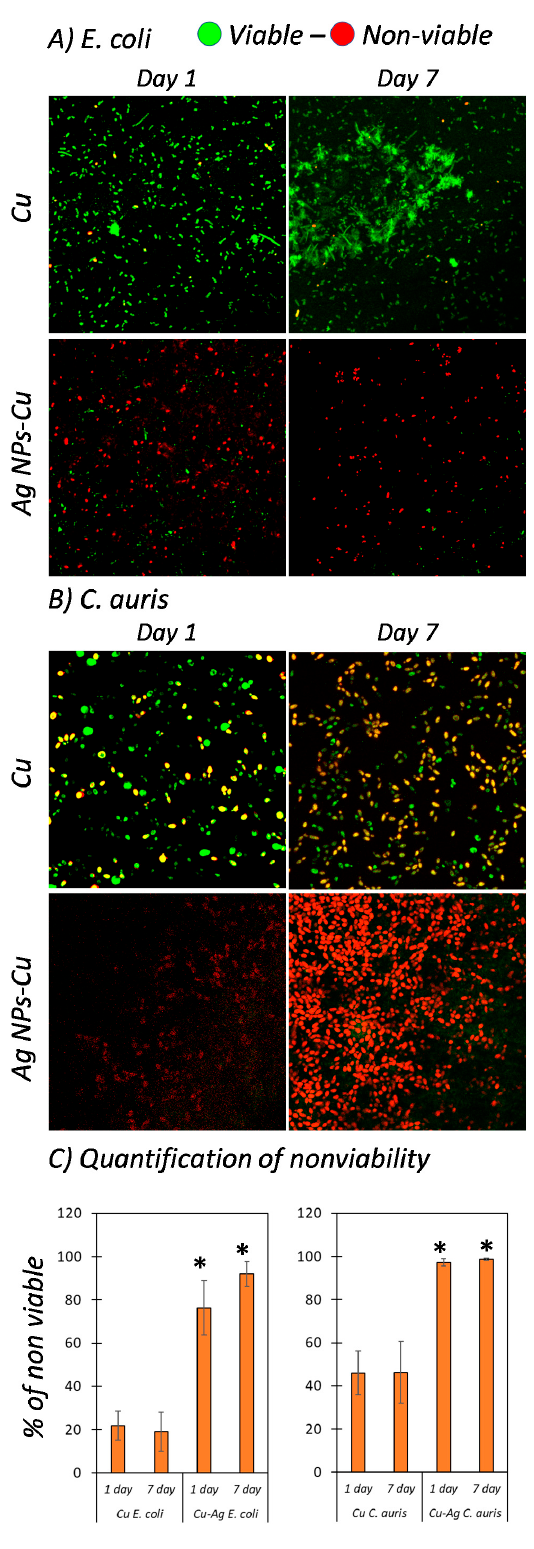
Figure 2. Assessment of Shiga-toxin-producing E. coli O157:H7 and C. auris on copper and Ag NPs-Cu surfaces over 1- and 7-day incubations. CSLM micrographs showing the viability of ( A ) E. coli and ( B ) C. auris on pristine Cu and Ag NPs-Cu surfaces (green indicating viable cells; and red indicating non-viable cells). CLSM images are 150 µ m × 150 µ m. ( C ) Quantification of cell viability on Cu and Ag NPs-Cu (* indicating p < 0.05 comparing with Cu surfaces on day 1 and 7, respectively, n =